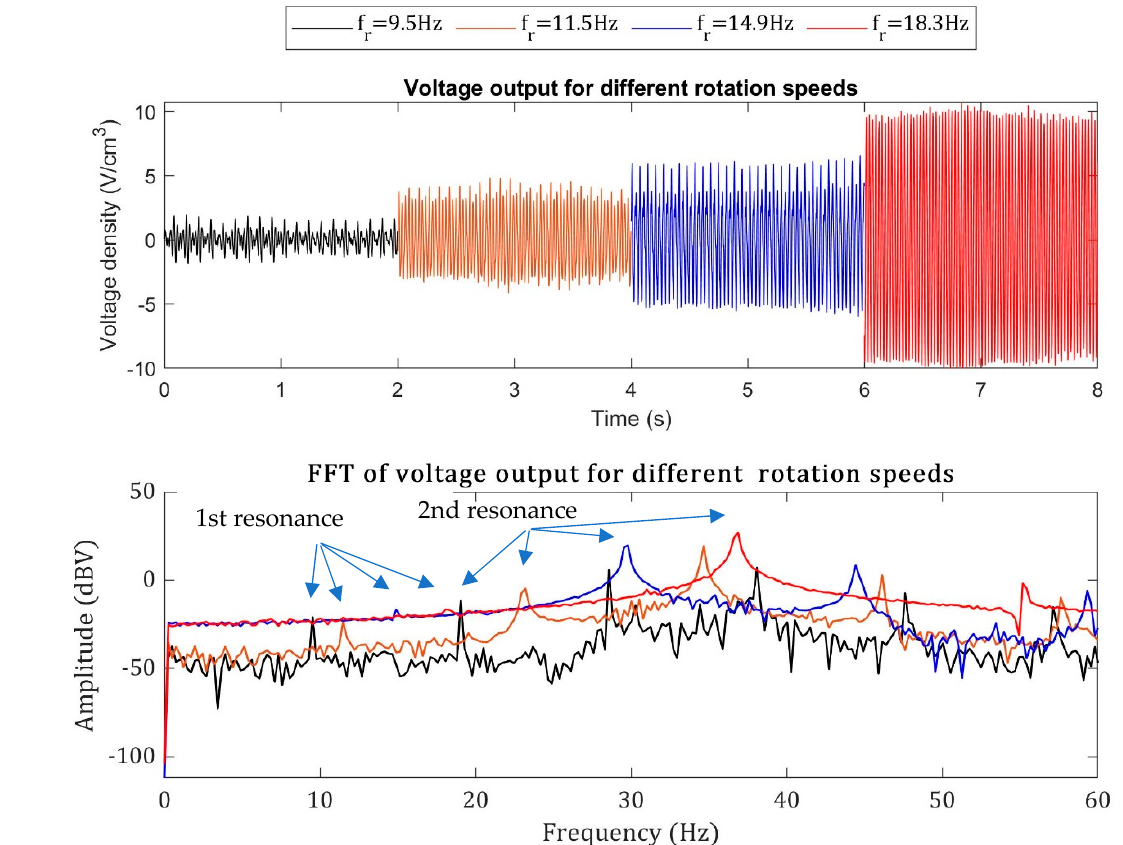
Figure 17. The open-circuit voltage output from the shaft-misaligned DC motor at different supply voltages. ( a ) The time-domain signals and ( b ) the FFT signals.